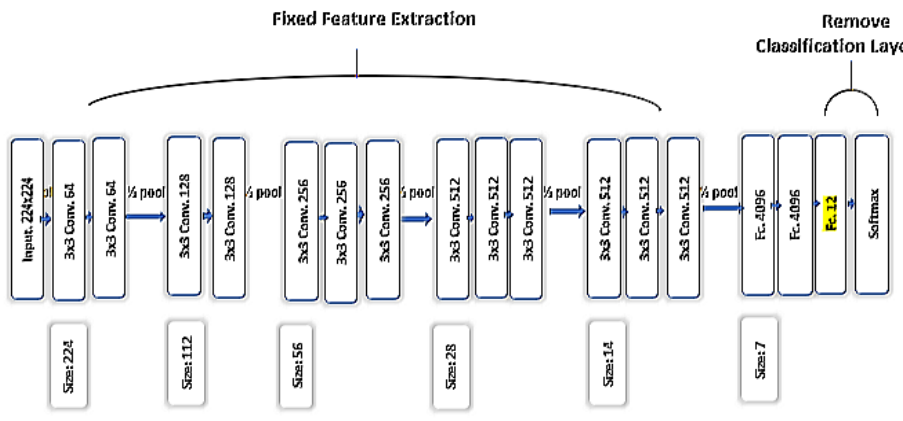
Figure 12. Use of transfer learning as a fixed feature extraction.